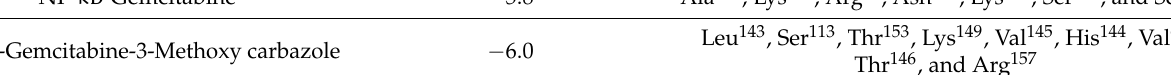
Figure 2. Ligplots showing the molecular interaction of the NF- κ B precursor p105 with ( A ) 3-Methoxy carbazole and ( B ) Gemcitabine.